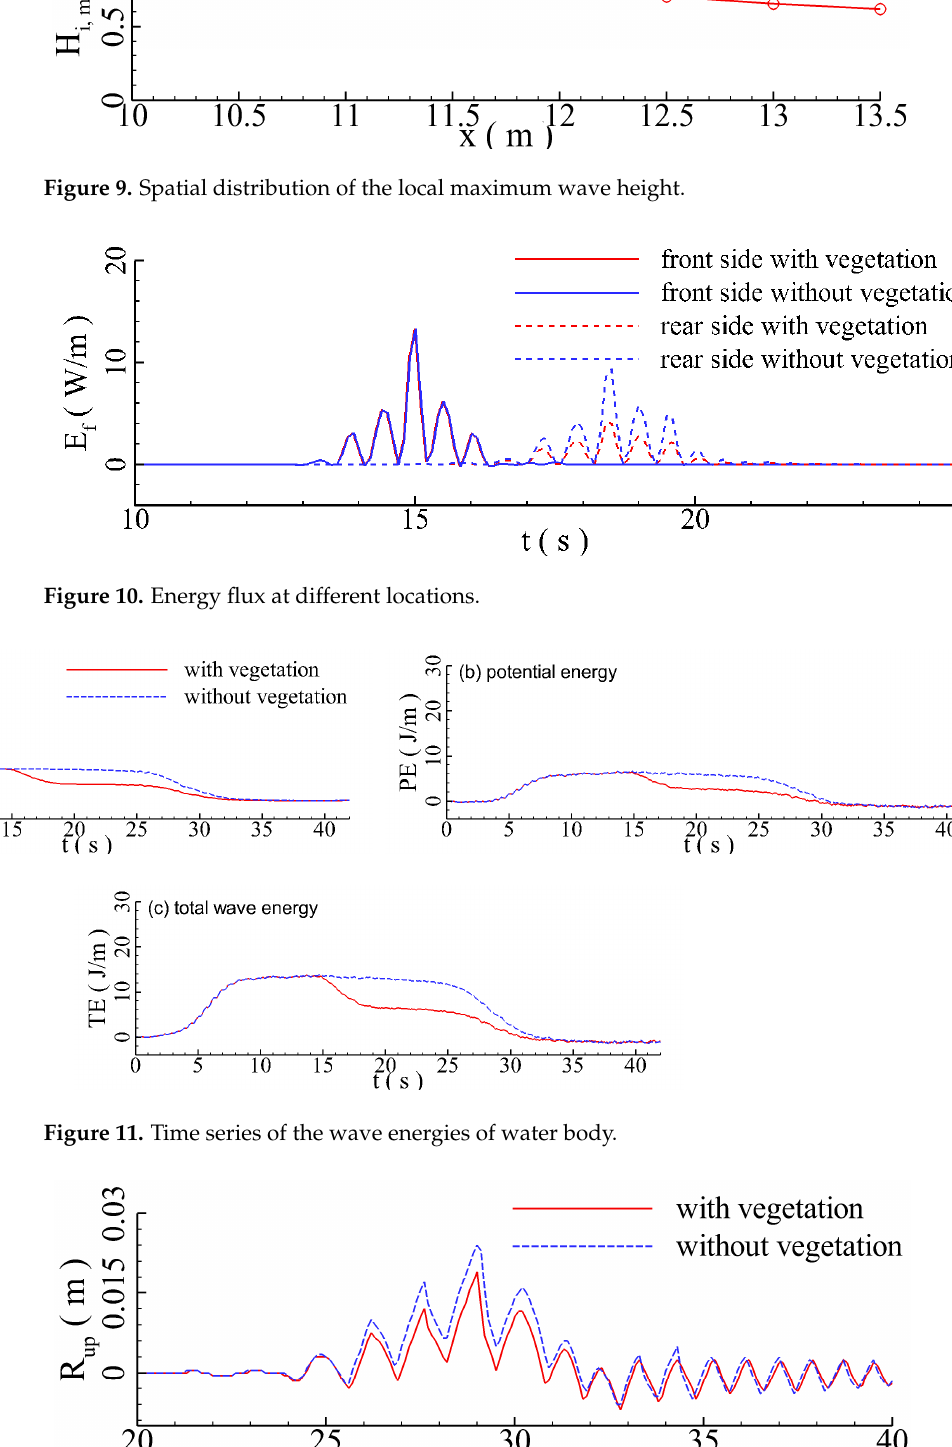
Figure 12. Time series of the wave runup height. 6.2. Effects of Significant Wave Height This section discusses the influences of the emergent vegetation patch on the runup processes of focused wave groups under different significant wave heights. Figure 13 de- picts the spatial distributions of local maximum wave height within the vegetation patch under different significant wave heights. When the vegetation patch is absent, the local maximum wave height of the focused wave group can only slightly decrease because of the bottom friction and the wave profile evolutions. Once the vegetation patch is present, the local maximum wave height of the focused wave group will be significantly de- creased. Moreover, difference between the local maximum wave height between the fo- cused wave groups with and without the vegetation at the rear side of the vegetation patch gradually increases with the significant wave height. Figure 14 depicts the variation in decreasing rate of the local maximum wave height at the rear side of the vegetation patch with the significant wave height. It clearly shows that the decreasing rate of the local maximum wave height linearly increases with the significant wave height. As the relative wave height ( 𝐻 (cid:3046) ℎ⁄ ) increases from 0.1 to 0.25, decreasing rate of the local maximum wave height increase by 19.0%. Figure 15 depicts the variation in wave energy dissipation rate